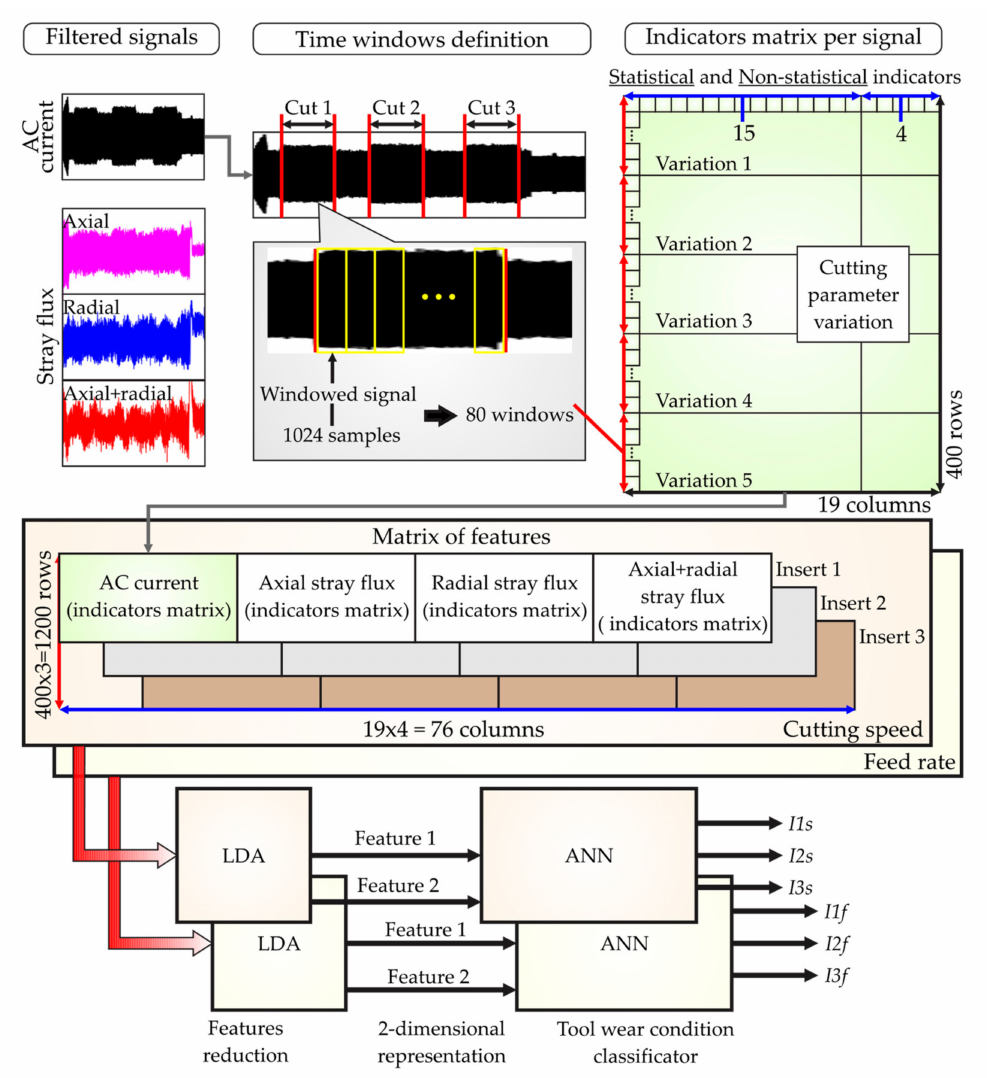
Figure 9. Experimental design for matrix of features computing and tool-wear condition